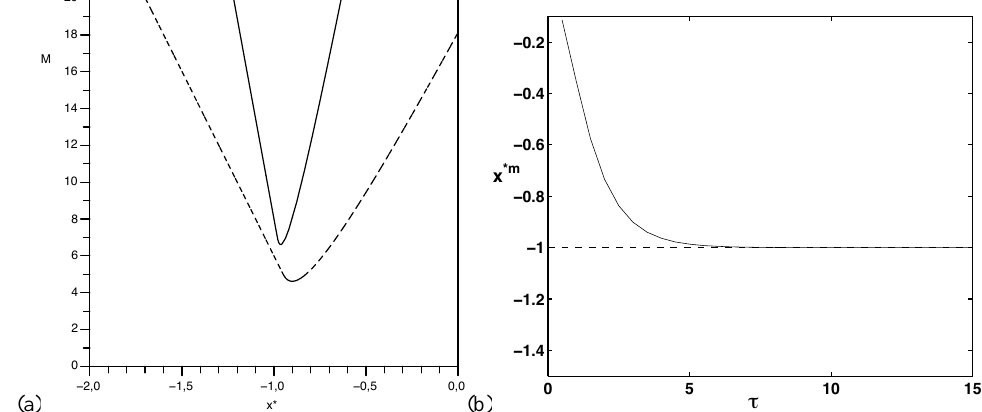
Fig. 9. (a) The function M at t = 0 for τ = 3 (dashed line) τ = 4 (solid line); b) evolution of the coordinate x *m at which M reaches a minimum versus τ at t = 0. (Figure taken from Madrid and Mancho, 2009).